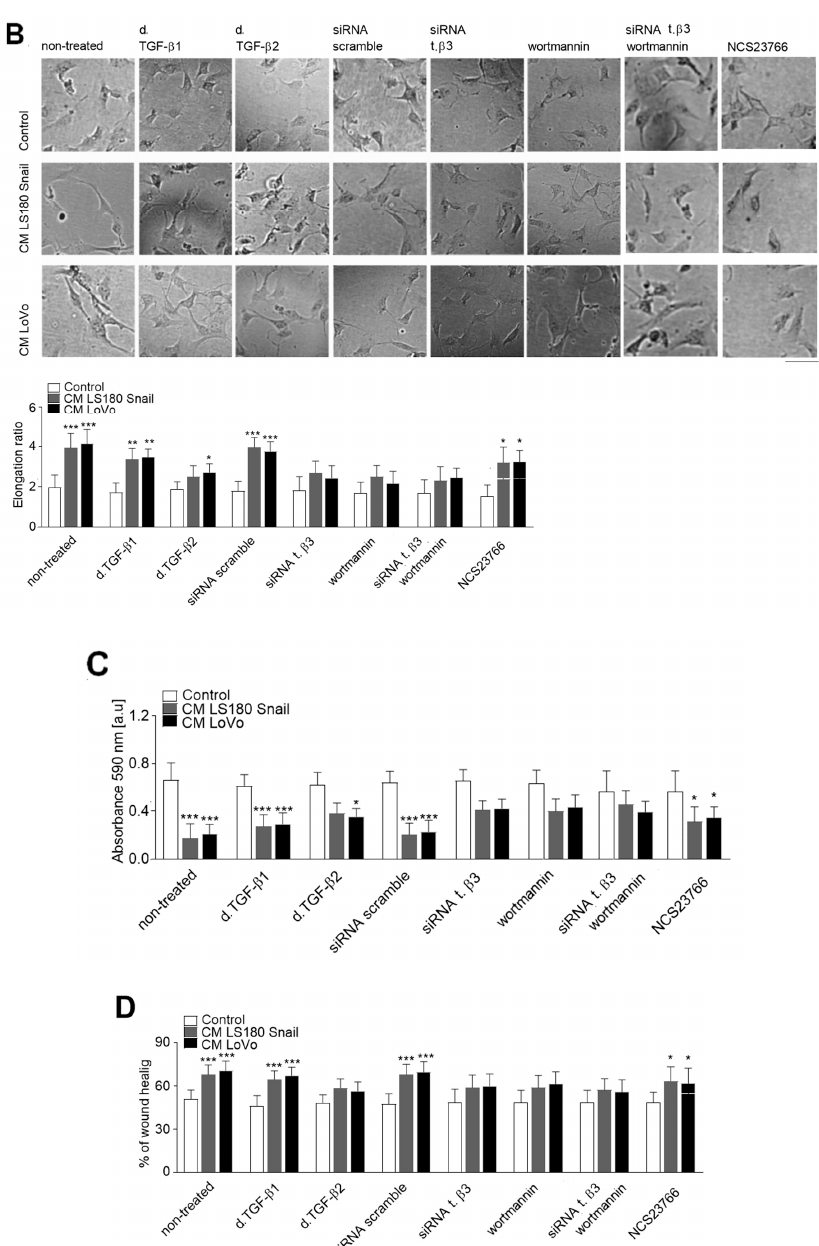
Figure 3. Phosphorylation of microtubular tubulin- β 3 regulates CAF behavior. HMEC-1 cells were cultured in medium supplemented with conditioned medium (CM) isolated from invasive (LS180 Snail, LoVo) colon cancer cells where TGF- β 1 or TGF- β 2 were depleted (d. TGF- β 1 or d. TGF- β 2) for 216 h or where tubulin- β 3 was silenced (siRNA t. β 3), or phosphorylation of tubulin- β 3 was inhibited by wortmannin. Additionally, in tubulin- β 3-silenced cells (siRNA t. β 3) the phosphorylation of tubulin- β 3 was inhibited by wortmannin or Rac1 was inhibited by NCS23766. Then, the phosphorylation of tubulin- β 3 in microtubule fraction from wortmannin treated-cells maintained in CM from invasive colon cancer cells (LoVo and LS180 Snail) ( A ) was determined by immunoprecipitation assay with rabbit antibodies recognizing phosphorylated protein. Next, the Western blot with mouse antibodies binding to tubulin- β 3 The morphology (20 × ) ( B ), adhesion to collagen I ( C ) and wound-healing properties ( D ) were